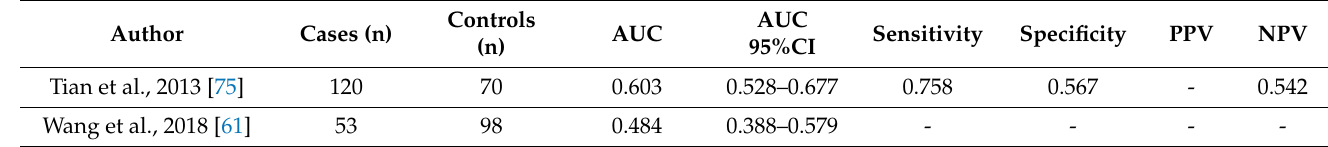
Table 12. Summary table of the performance of Visfatin.